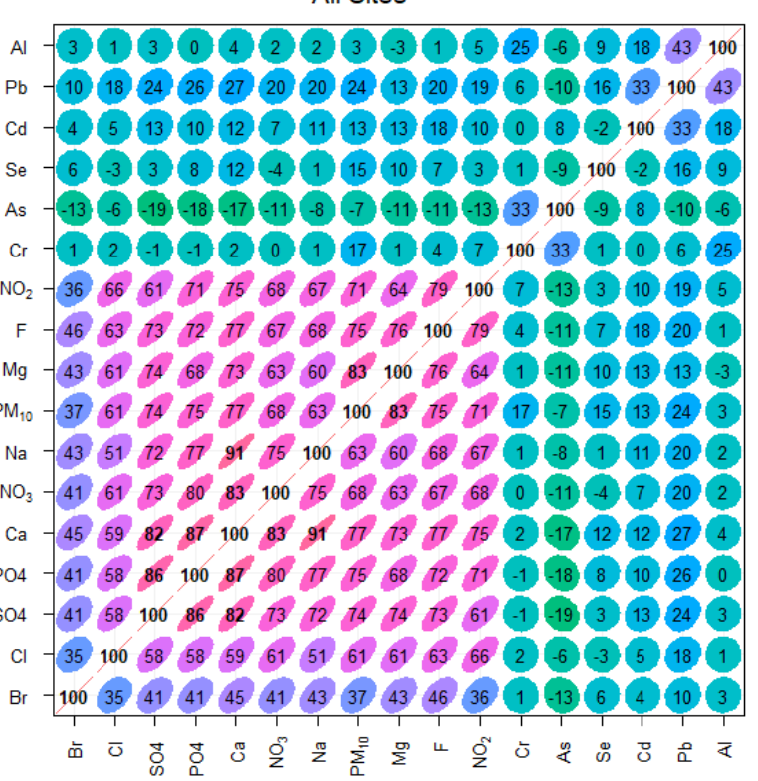
Figure 4. Correlation plots of PM 10 , trace elements, and ions for ‘all sites’ in Makkah (individual sit es are not shown for are not shown for brevity).